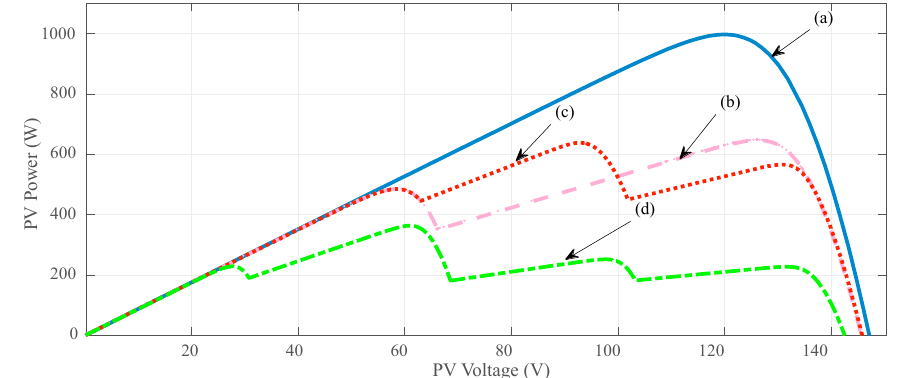
Figure 9. PV characteristics under different levels of partial shading. Table 4. PV characteristics study for a different type of shading.